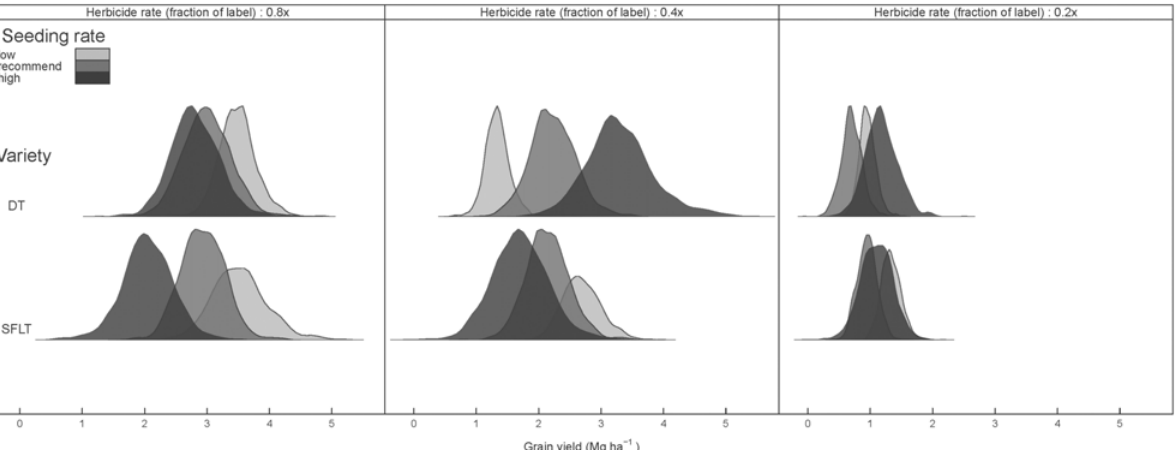
Fig 6. Posterior predicted yields for drought tolerant spring wheat (DT) and Cephus cinctus tolerant spring wheat (SFLT) spring wheat varieties at three seeding densities and under 0.8x, 0.4x, and 0.2x herbicide rate treatments